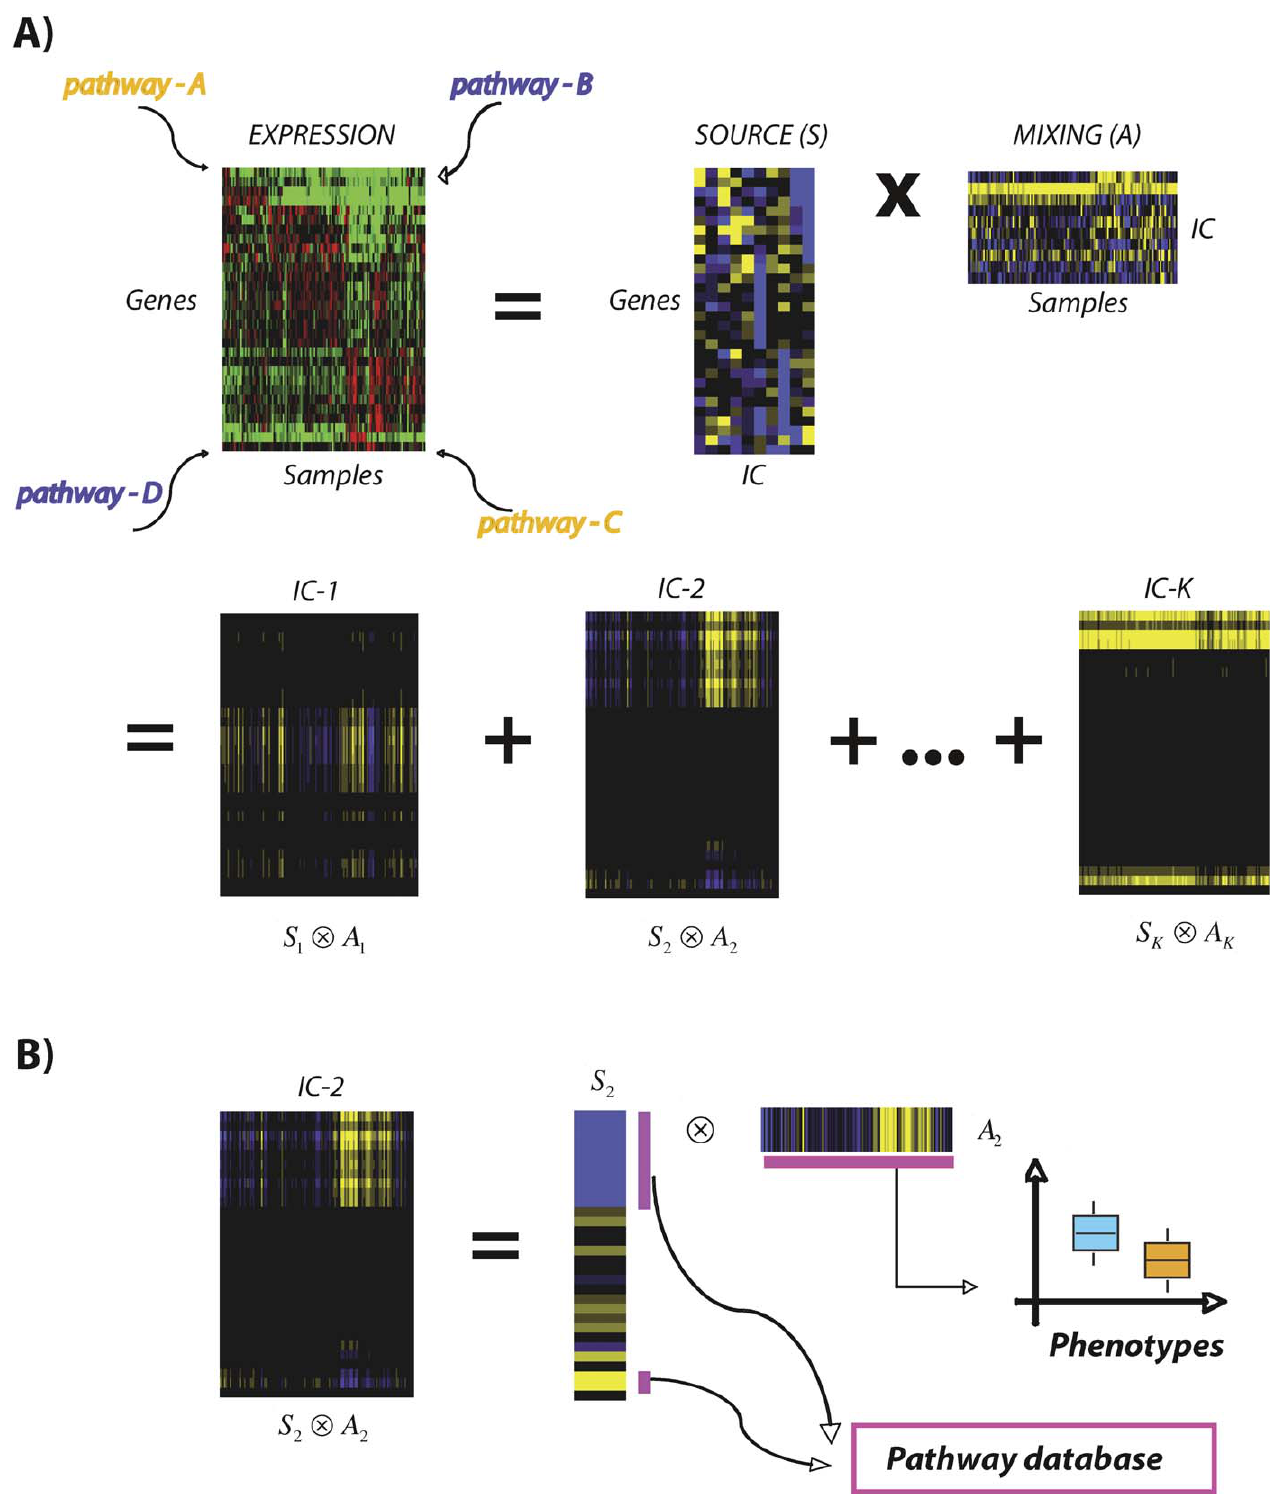
Figure 1. The ICA Model of Gene Expression Schematic depiction of the ICA model for gene expression. (A) Measured gene expression variations are caused by alterations in the activation levels of biological pathways. In the ICA model, the gene expression matrix is decomposed into the product of a ‘‘ source ’’ matrix S and a ‘‘ mixing ’’ matrix A , where K is the number of inferred independent components (IC) to which pathways and regulatory modules map. The columns of S describe the activation levels of genes in the various inferred independent components, while the rows of A give the activation levels of the independent components across tumor samples. The product of S and A can be written as a sum over the IC submatrices IC -1, IC -2,... IC - K . (B) IC – k –submatrix is obtained by multiplying the k -th column of S , S k , with the k -th row of A, A k . The genes with the largest absolute weights in S k are